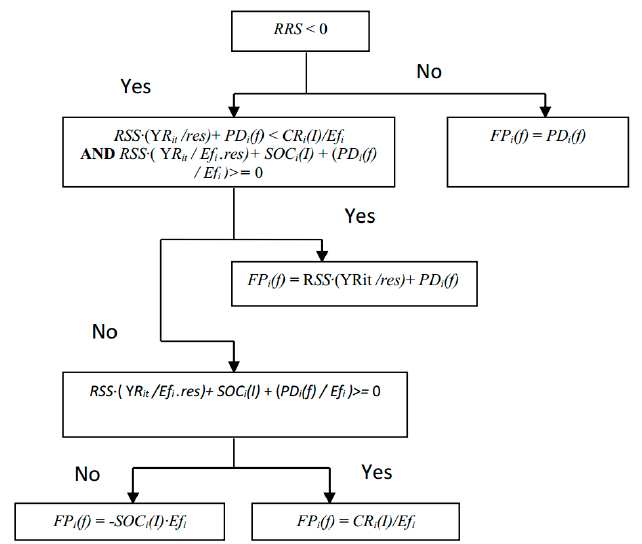
Figure 3. Power draw calculation of a battery after performing a responsive reserve service.